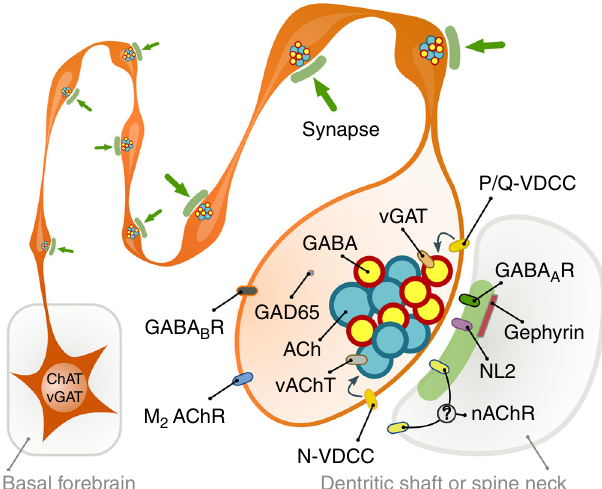
Fig. 7 Illustration of cholinergic terminals and their synaptic architecture. Summary illustration of some of the fi ndings. All cholinergic terminals establish synapses, they are fully equipped with GABAergic – cholinergic co- transmission signalling machinery. GABAergic and cholinergic vesicles are regulated by different VDCCs. Although postsynaptic cholinergic receptor distribution cannot be investigated, their response latencies (that are at least and order of magnitude faster that typical non-synaptic transmission) receptors are detected intra-synaptically. Synapses are established on both dendritic shafts and spines in